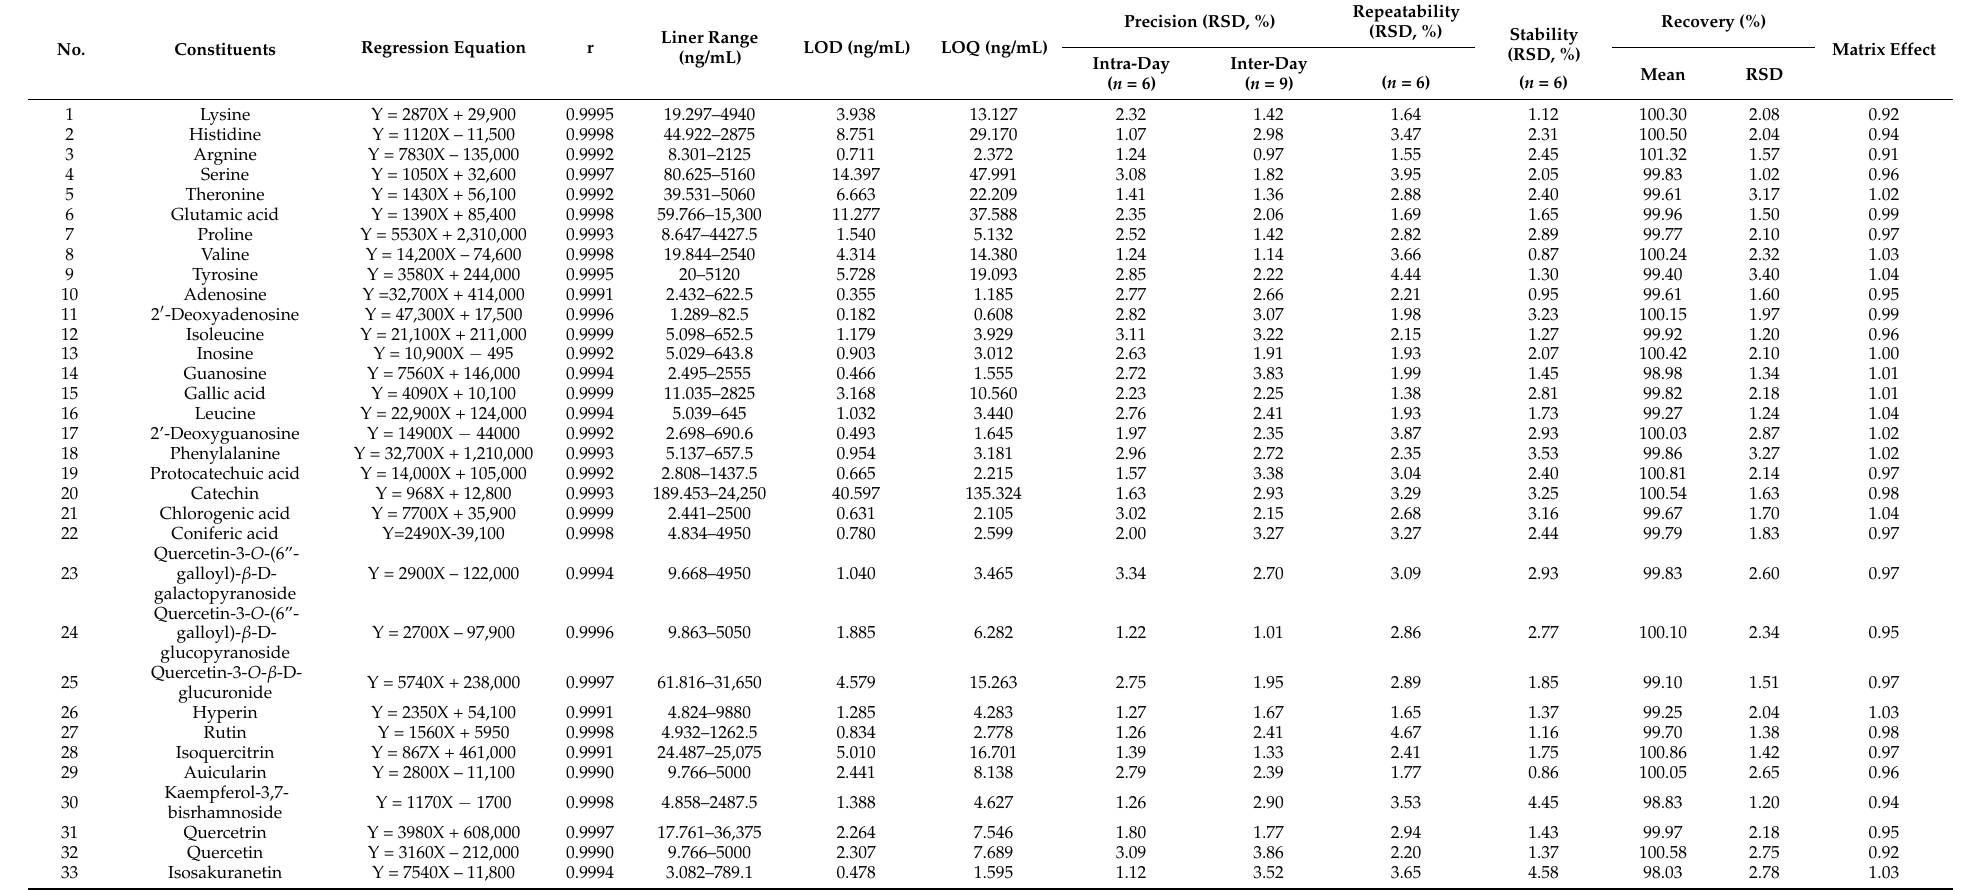
Table 2. Regression equations, limits of detection (LOD) and limits of quantification (LOQ), precision, repeatability, stability, recovery, and matrix effect of 33